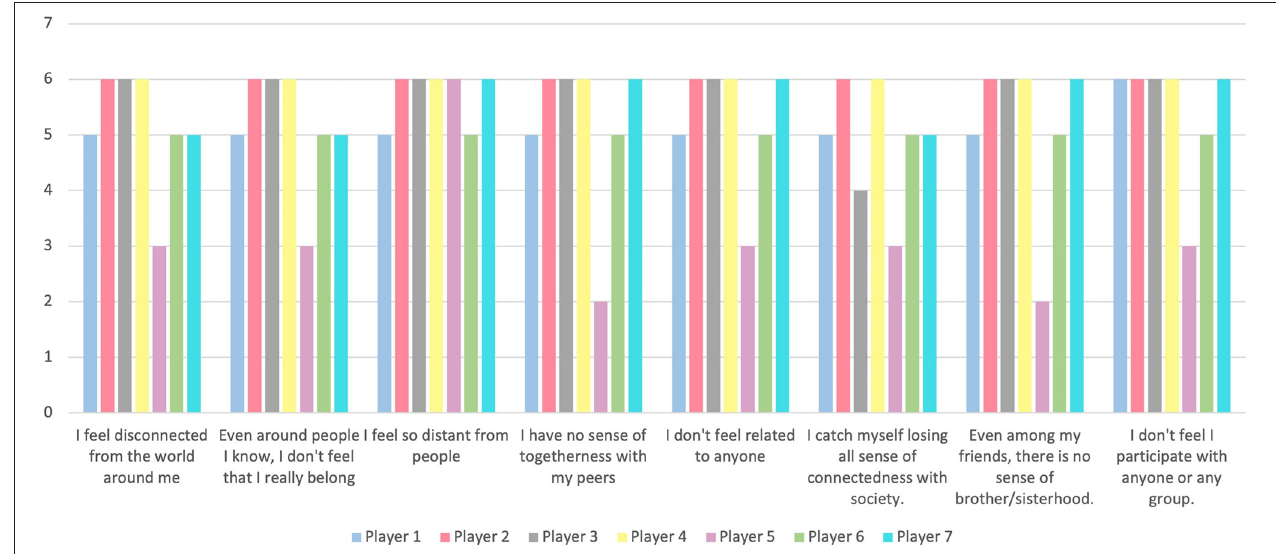
FIGURE 4 | Variability in Social Connectedness Scale (SCS) scores between players by